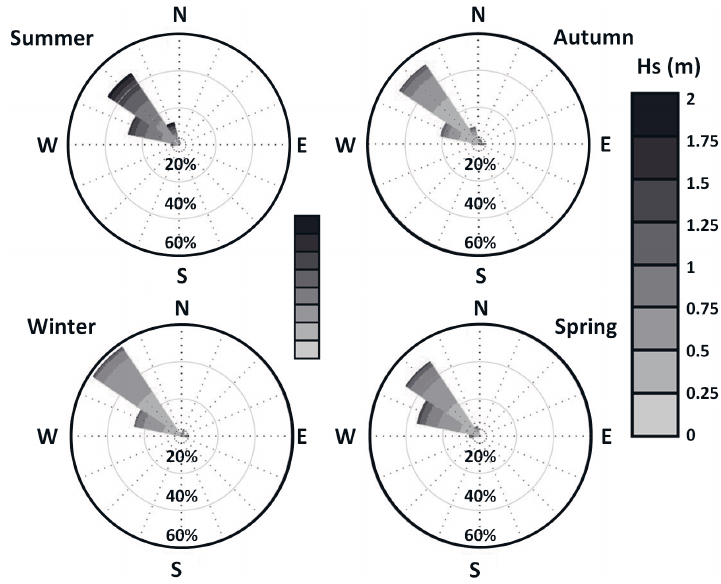
Figure 5. Seasonal wave roses at Bn15 for November 2006 to August 2011.